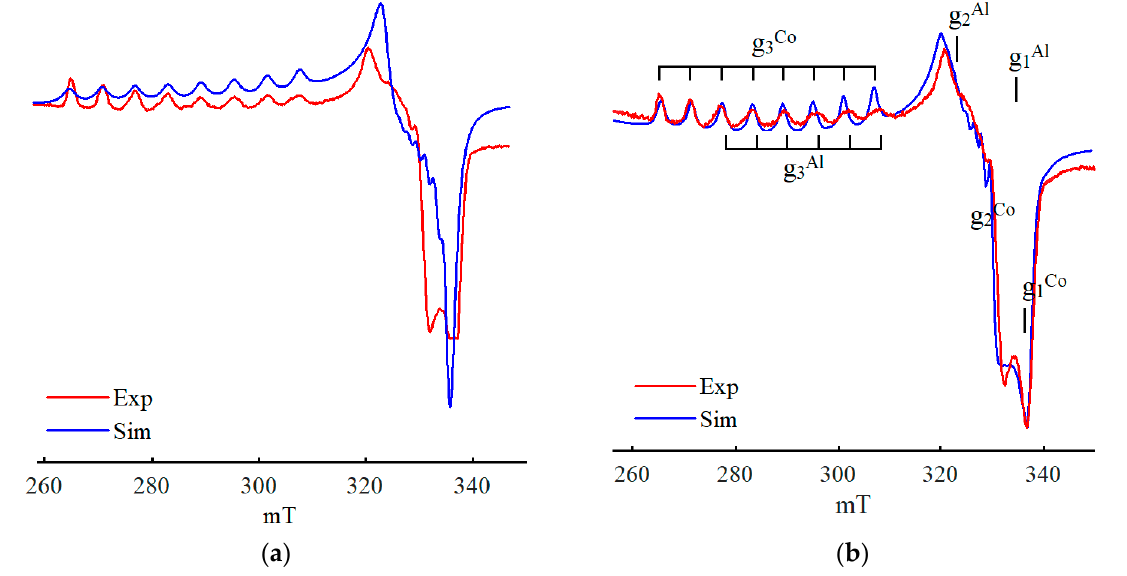
Figure 8. Real (red line) and simulated (blue line) EPR spectra of the Co(acac) 2 –AlEt 3 catalytic system formed in toluene in an argon atmosphere (T = 77 K): ( a ) from [69,77], ( b ) made for this work.